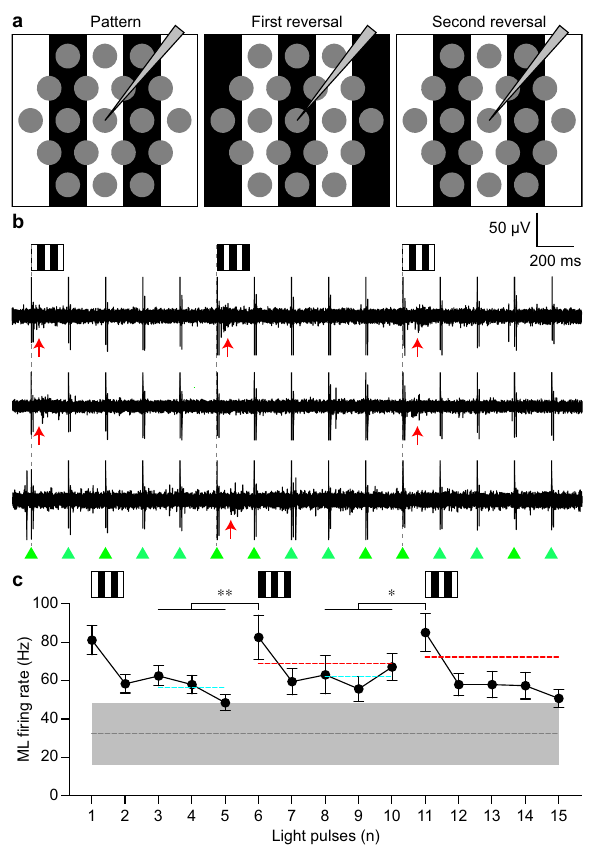
Fig. 7 Grating pattern reversal with a fi xed bar width. a Sketch of the grating pattern reversal with a fi xed bar width. A grating pattern with black and green 120- µ m wide vertical bars (560 nm, 10 ms, 0.9 mW mm − 2 ) was projected onto the array with a 5-Hz illumination rate for 3 s and reverted every fi ve pulses. b Raw electrophysiological recordings of three RGCs under grating pattern reversal with a fi xed bar width. The green triangles correspond to the onset of each light pulse. The fi rst pattern and the reversals are highlighted by the grey dashed lines. The red arrows highlight ML activity. c Quanti fi cation of the ML fi ring rate (mean ± s.e.m.) under grating pattern reversal with 120- µ m bar width ( n = 26 RGCs). The cyan dashed lines are the average desensitised ML fi ring rates and the red dashed lines are the recovery thresholds. The grey dashed line is the average resting fi ring rate with its s.d. represented by the grey area.